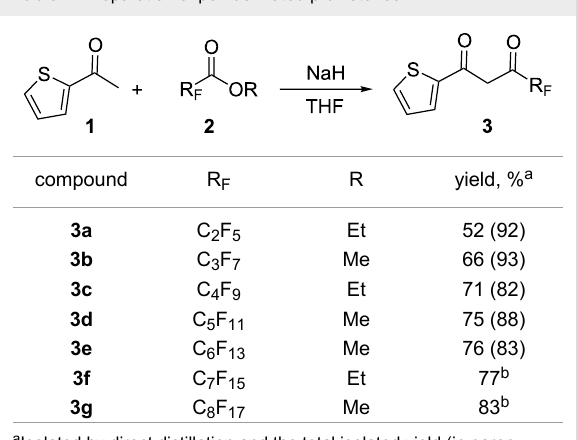
Table 2: Preparation of perfluorinated β